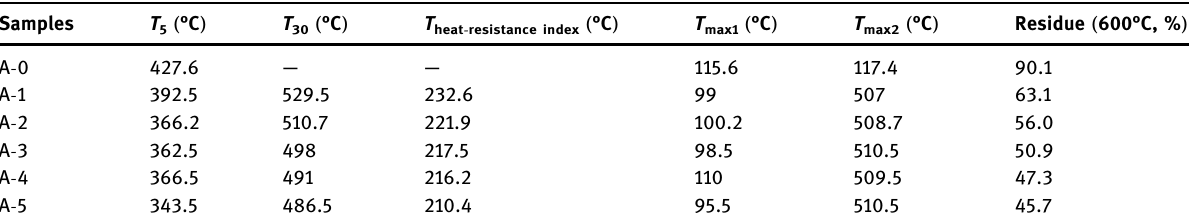
Table 3: Thermal decomposition parameters of NBR/BPF composites Samples